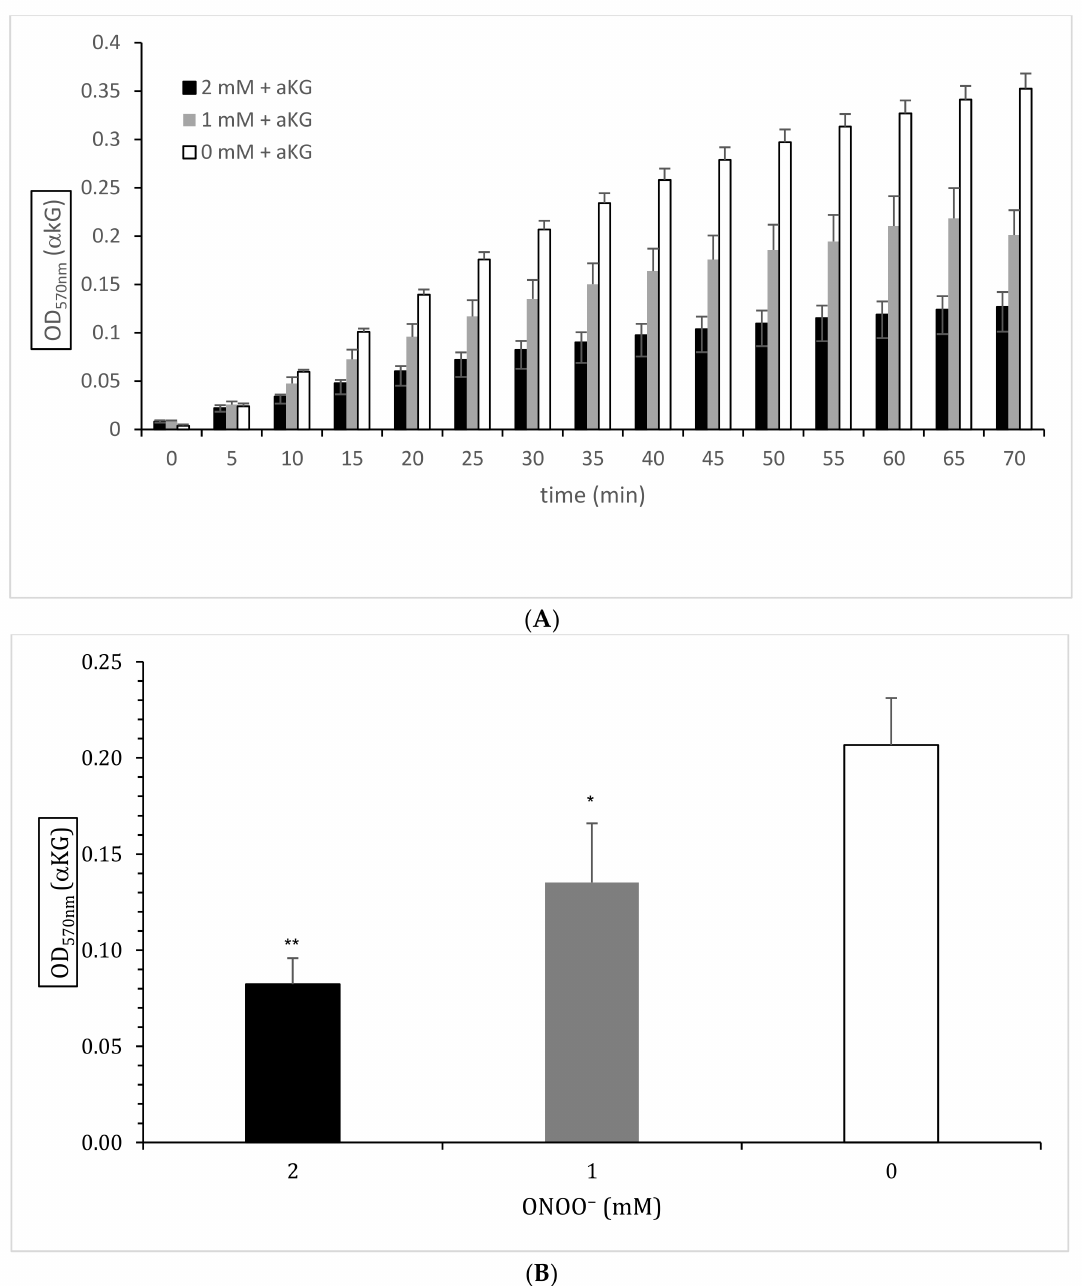
Figure 2. Spectrophotometric estimation of α KG (OD 570 nm) absorbance via an enzyme reaction mix in the absence or presence of 0 mM (white bars; n = 5), 1 mM (grey bars; n = 5), or 2 mM (black bars; n = 5) ONOO − between 0 and 70 min ( A ) and after 30 min according to the protocol ( B ). * p < 0.01: significant compared to the control (0 mM ONOO − , white bar); ** p < 0.001: significant compared to the control (0 mM ONOO − , white